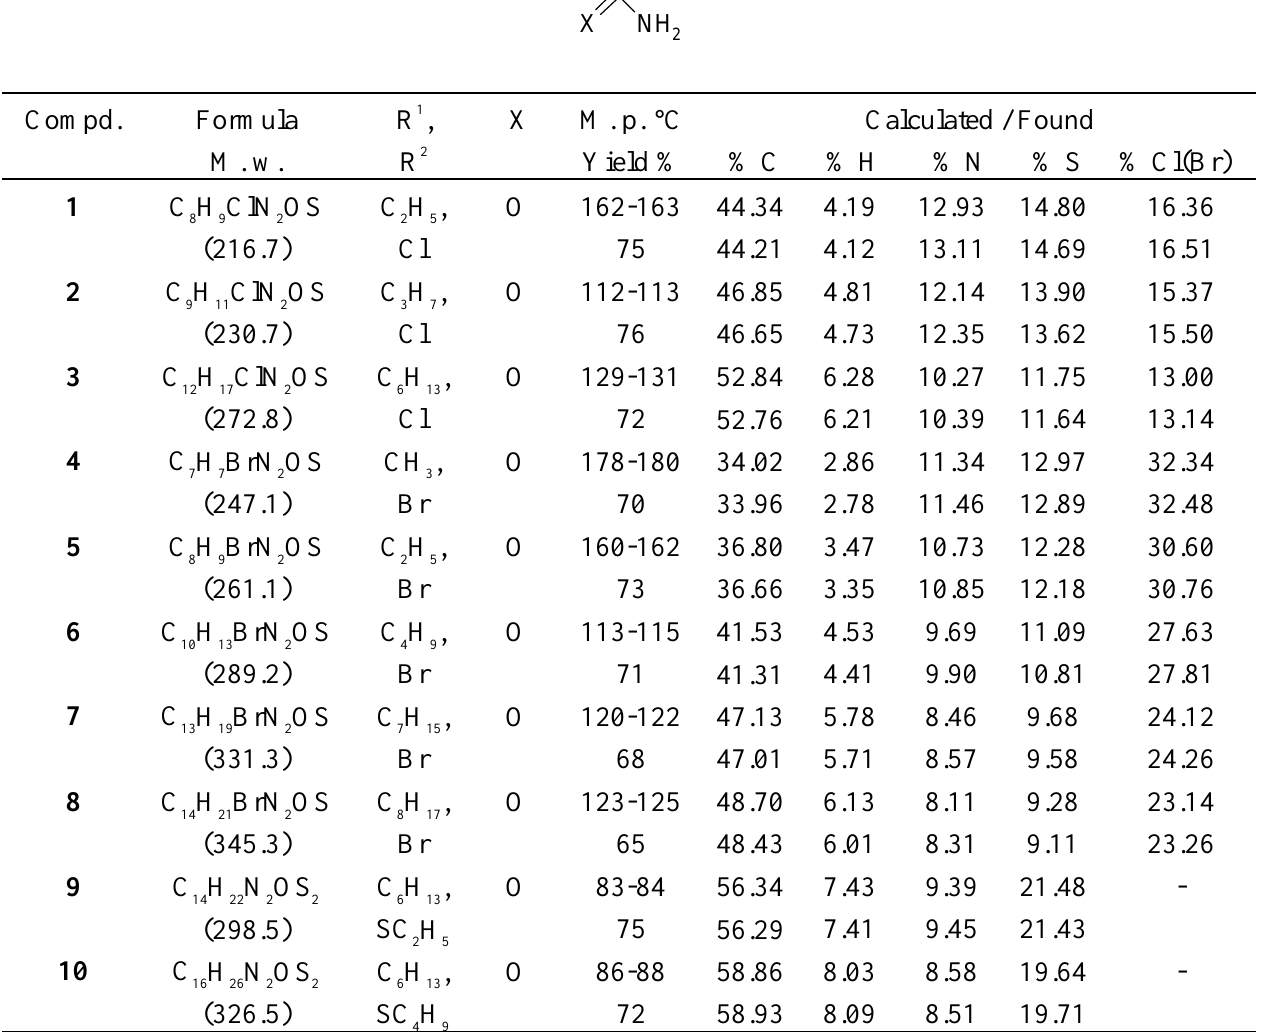
Table 1. Analytical data of the prepared compounds